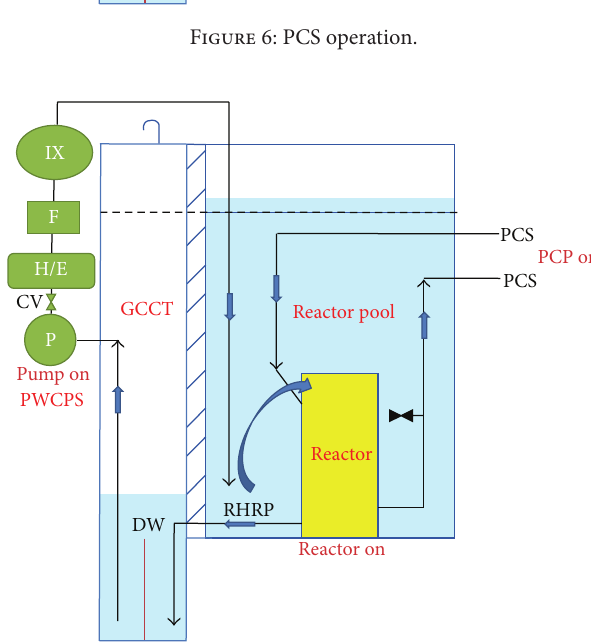
Figure 6: PCS operation.